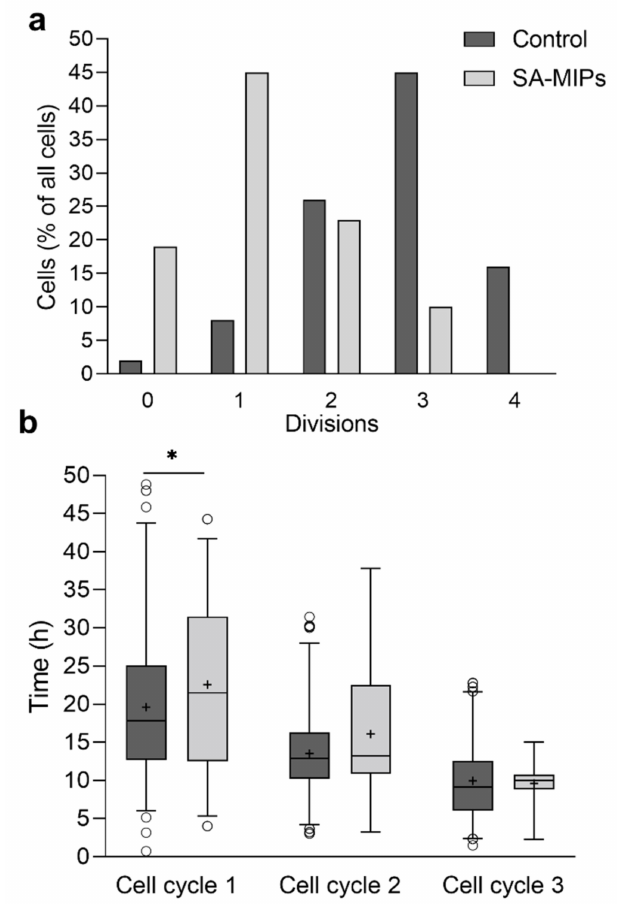
Figure 8. Number of cell divisions and length of individual cell divisions in the presence or absence of SA-MIP. Cells were grown with 0 or 40 µ g/mL SA-MIPs for 48 h. Images were captured using DHC time-lapse. Cell families were tracked longitudinally using App Suite. Data obtained from longitudinal tracking of cells are presented in supplementary data Figure S1. ( a ) shows the relative numbers of cell families undergoing none, one, two, three or four divisions observed during 48 h for all tracked cells in the first timepoint of the experiment are presented. ( b ) shows the length (h) of individual cell cycles for RAW 264.7 cells with 0 or 40 µ g/mL SA-MIPs. In total 109 untreated cell families and 91 SA-MIPs-treated cell families were longitudinally tracked. In the box plot, + marks the mean value, and the whiskers represent the smallest and largest observations (2.5–97.5%) with the circles (O) representing the